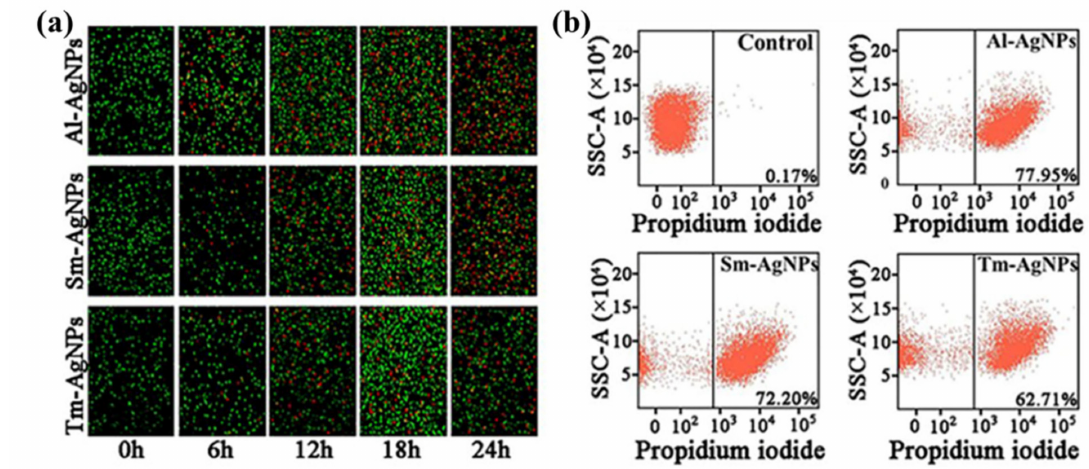
Figure 6. Direct killing effect of Al-AgNPs, Sm-AgNPs and Tm-AgNPs on Xoo strain C2 ( a ) Live/dead cell staining analysis. ( b ) Flow cytometry